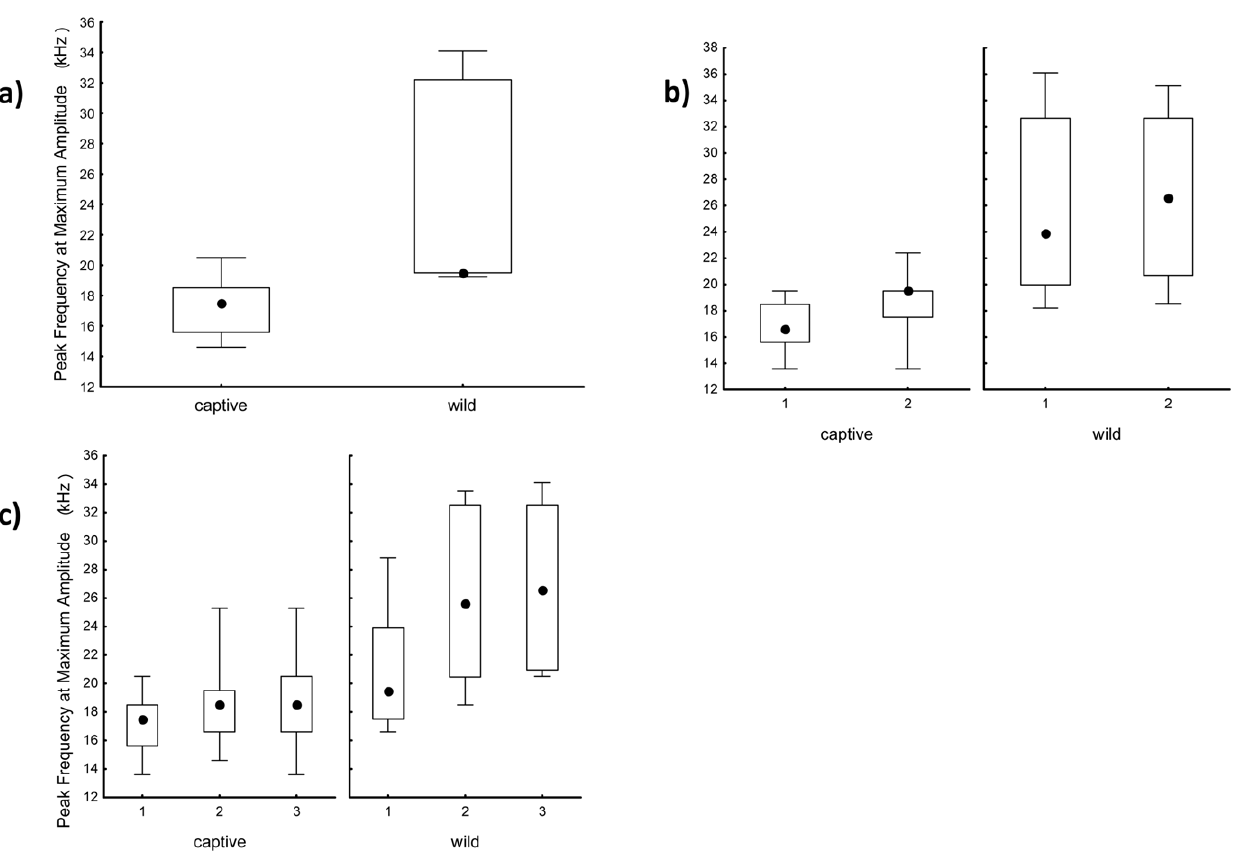
Figure 2. Frequency at maximum amplitude of USVs recorded from P.californicus in the wild and laboratory. Box (25% and 75% quartiles) and whisker (ranges) plots of median values (closed circles) of peak frequency of maximum amplitude for a) 1SVs, b) 2SVs, and c) 3SVs recorded from P. californicus in captivity and in the wild (sample sizes as in Fig 1).